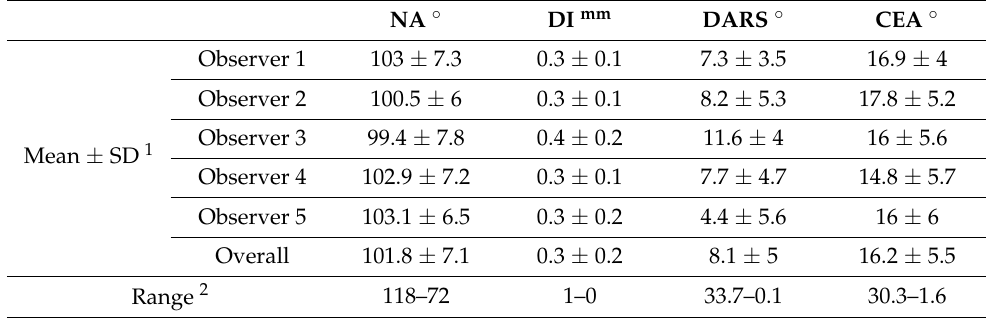
Table 1. Descriptive statistics of the measured quantitative values in four-month-old Rottweilers.